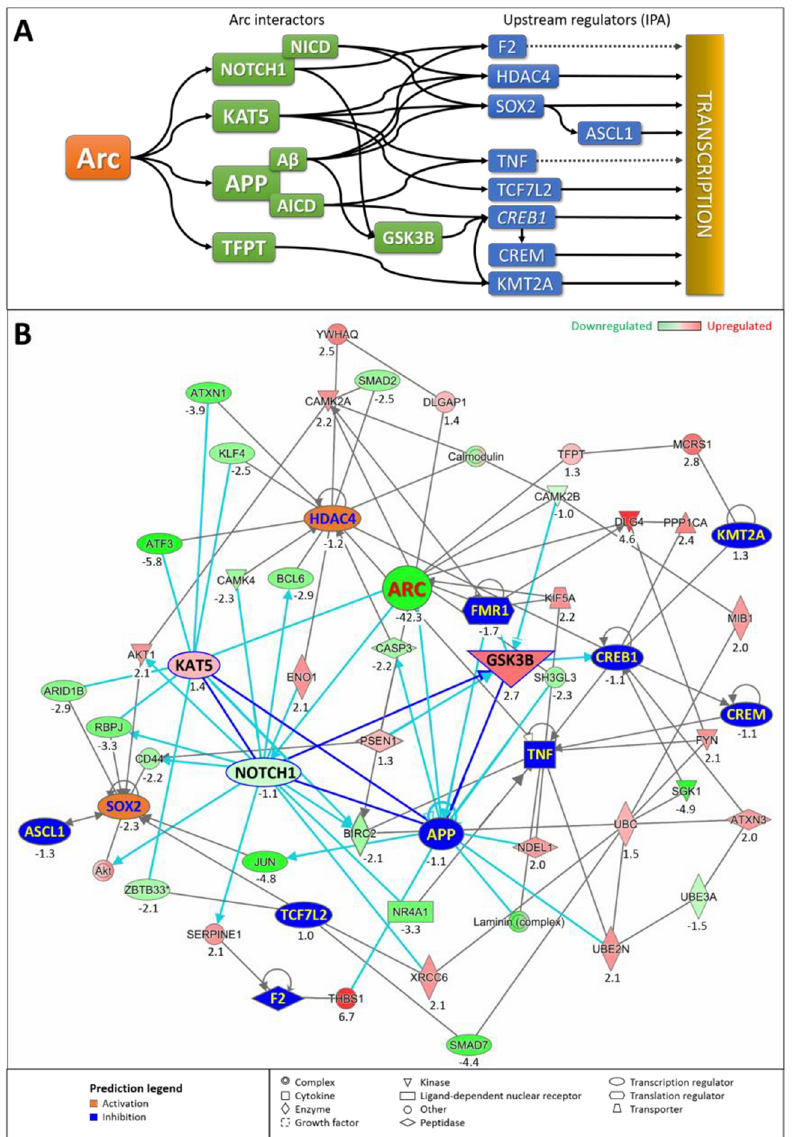
Figure 20. Regulation of upstream regulators by Arc interactors. ( A ) Schematic diagram illustrat- ing how interactors of Arc could bring about changes in activity of upstream regulators identified by IPA, which in turn results in alteration of gene transcription. The dotted line indicates an indirect effect on transcription through the regulation of a transduction cascade. ( B ) Diagram showing the functional connectivity between Arc interactors (KAT5, NOTCH1, GSK3B and APP), upstream regu- lators highlighted in orange (activated) or blue (inhibited) and genes that mediate their interaction. Connections of Arc interactors with other genes are highlighted in cyan. Connections between KAT5, NOTCH1, GSK3B and APP are highlighted in blue. Genes from A are shown in